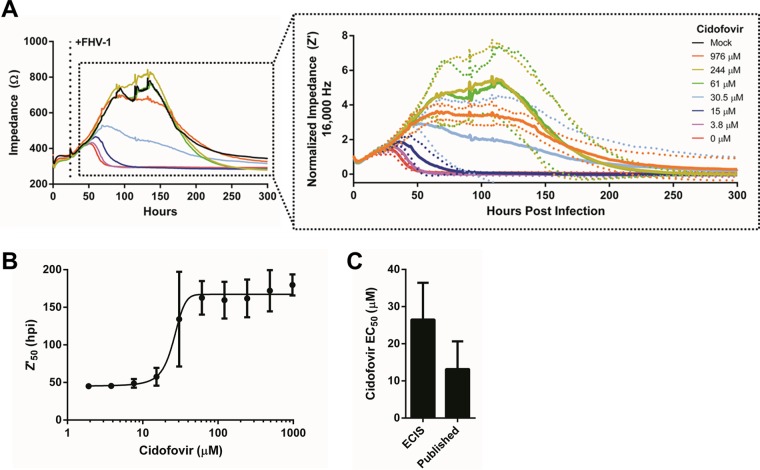
ECIS accurately determines the EC50 of the antiviral cidofovir. (A) CRFK cells were infected with MOI of 0.01 of FHV-1 and treated with 2-fold dilutions of cidofovir (ranging from 976 to 1.9 μM) at 24 hpp. Nontreated FHV1-infected and mock-infected CRFK cells were included as controls. The insert shows normalized impedance values (Z′) following FHV-1 infection and cidofovir treatment. For clarity, only Z′ values for a selected set of cidofovir concentrations are shown. (B) Dose-response curve of the Z′50 value of each cidofovir concentration used to determine the EC50. (C) Comparison of the EC50 of cidofovir as determined by ECIS in the present study to previously published EC50 values determined by standard plaque reduction assays (25–27). No significant difference between ECIS-based and previously published EC50s was observed.